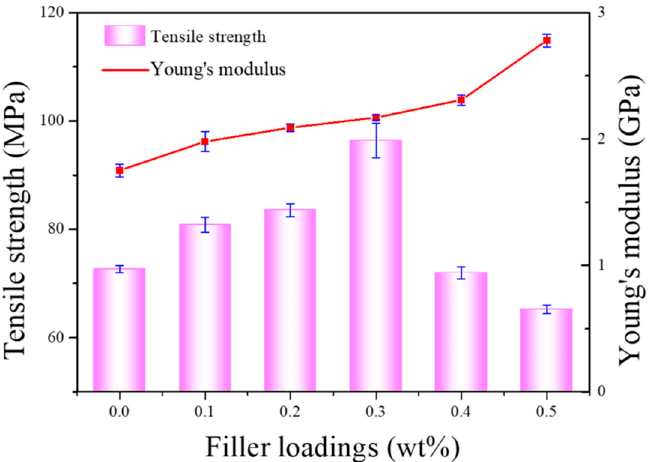
Figure 11. The effect of filler loading on the tensile strength and Young’s modulus of pure PA66 and EG/PA66 composites. Table 1. Comparison of literature data with this work for the mechanical properties of PA66